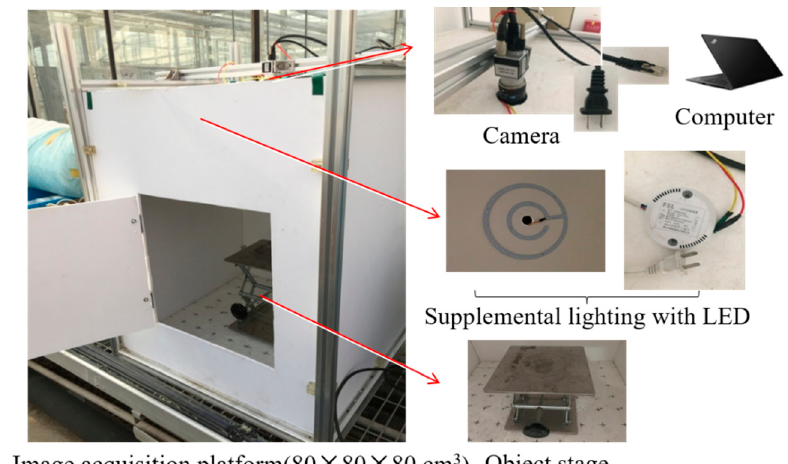
Figure 1. Image acquisition platform.